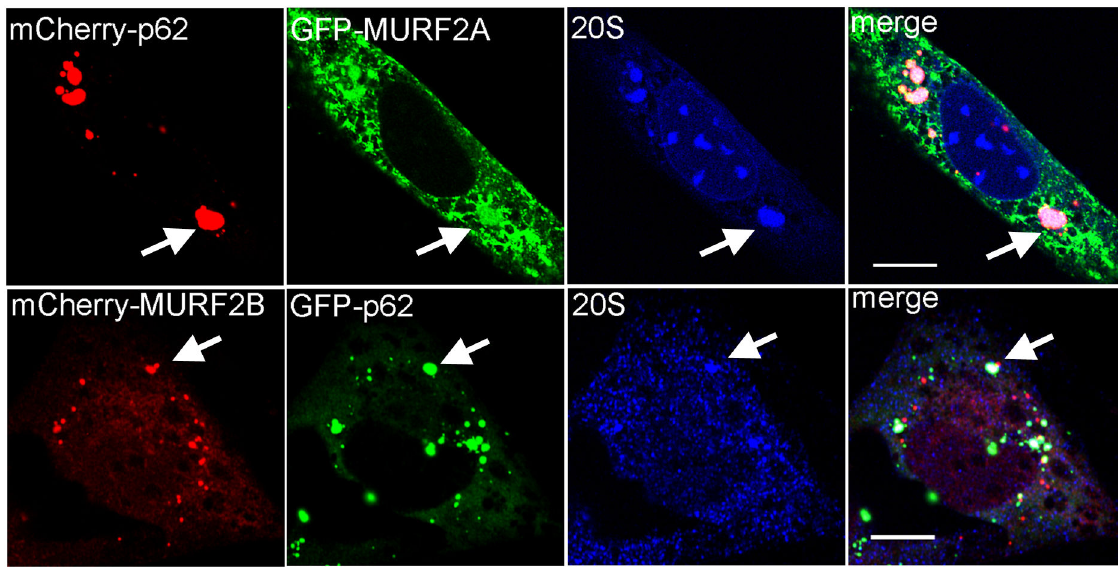
Figure 10. Confocal analyses of p62, UPS and MURF2 proteins in differentiated C2C12 cells. C2C12 cells were transfected with plasmids expressing the fluorescent proteins as indicated and differentiated for 24h. Confocal observations: fluorescent proteins were detected directly and the 20S proteasome subunit revealed by specific antibody for the α5 subunit of the 20S proteasome. Scale Bars: 10